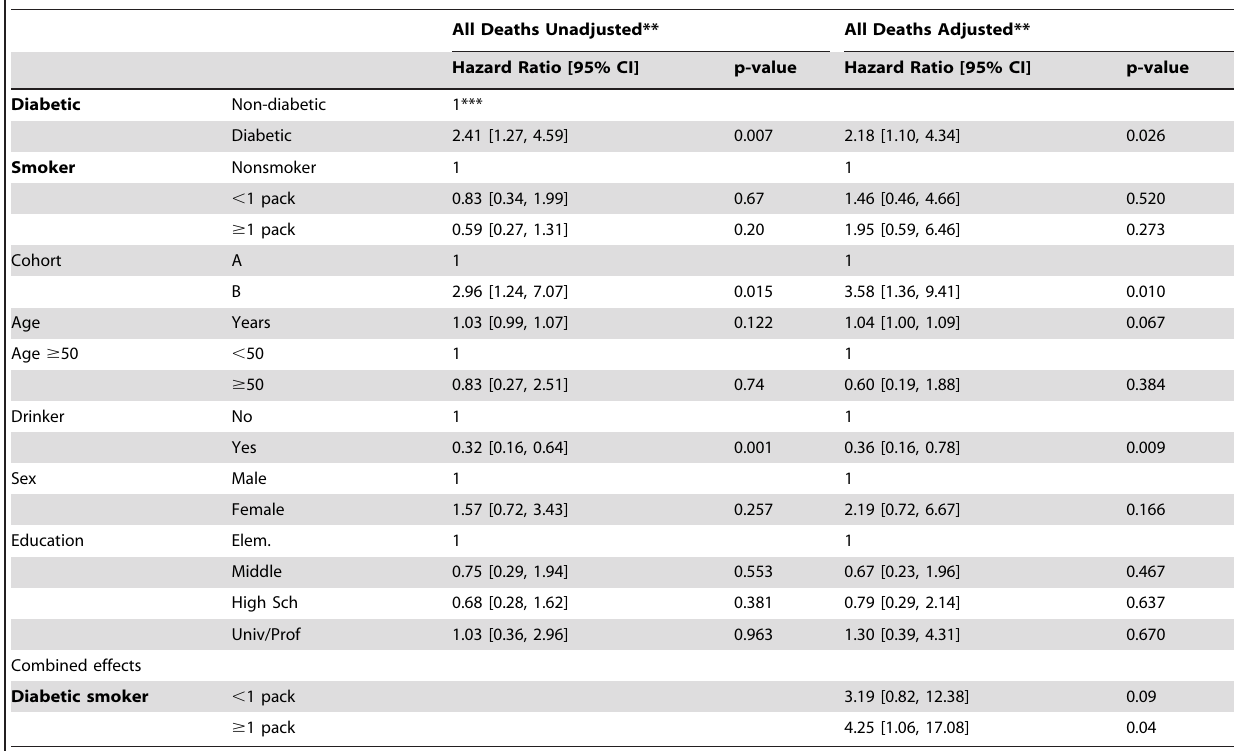
Table 5. Impact of diabetes and smoking on all cause one-year